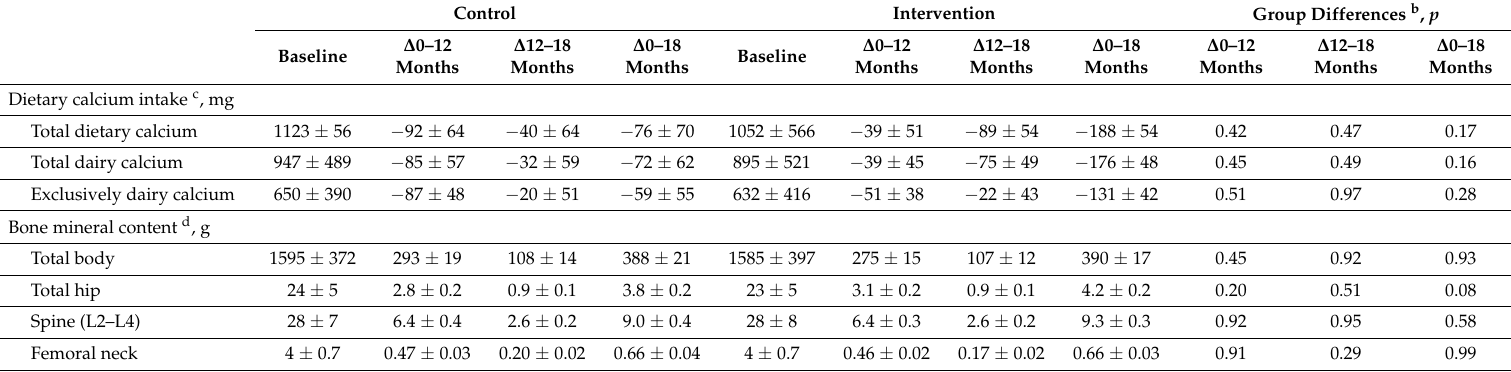
Table 2. Calcium intake and bone mass among early adolescent girls by treatment group at baseline and change at follow-up visits a.